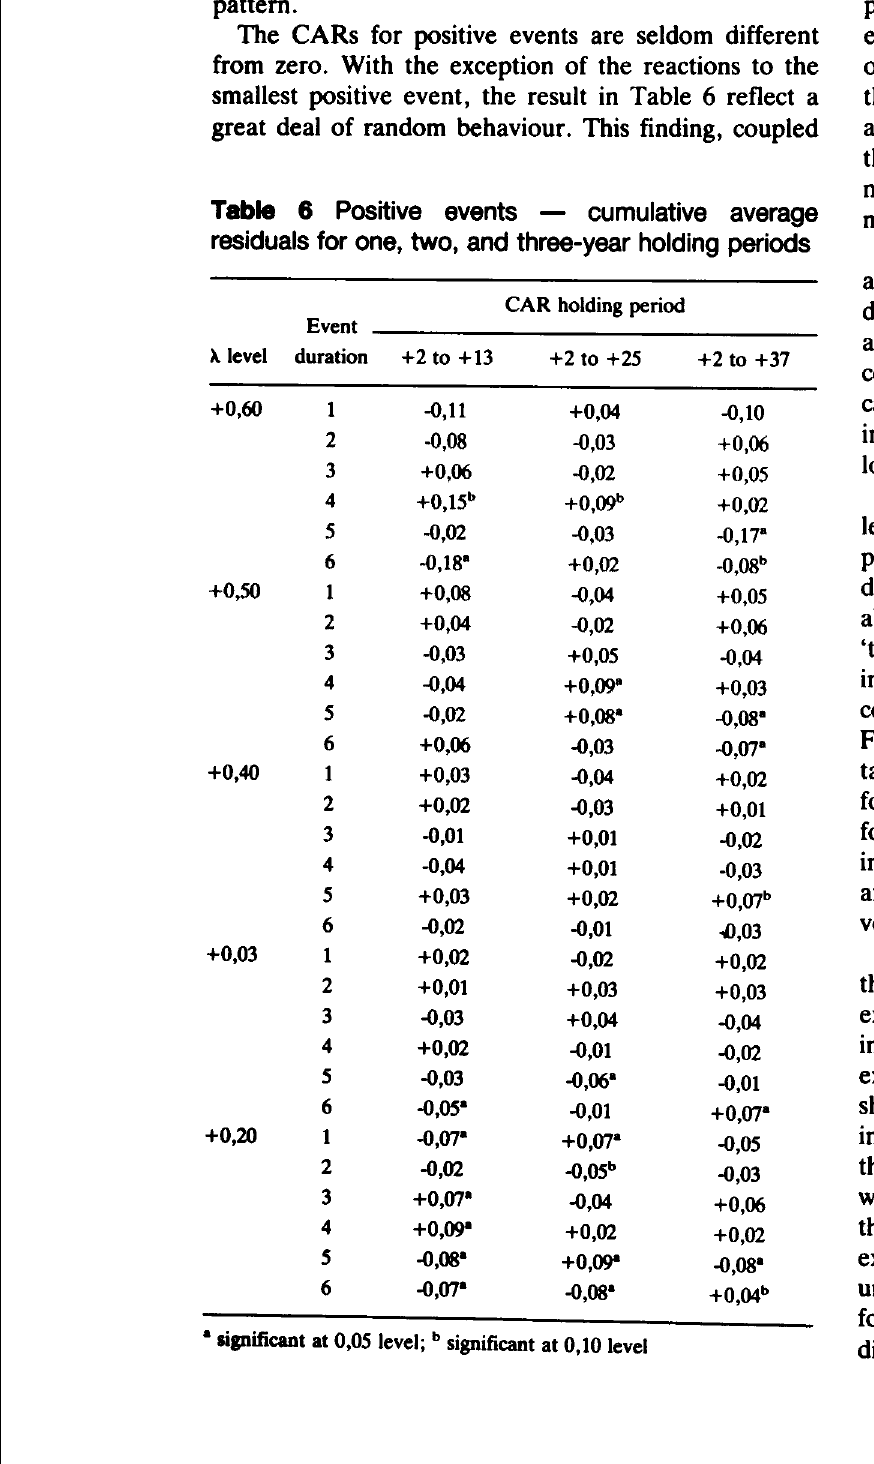
cumulative average CAR holding period